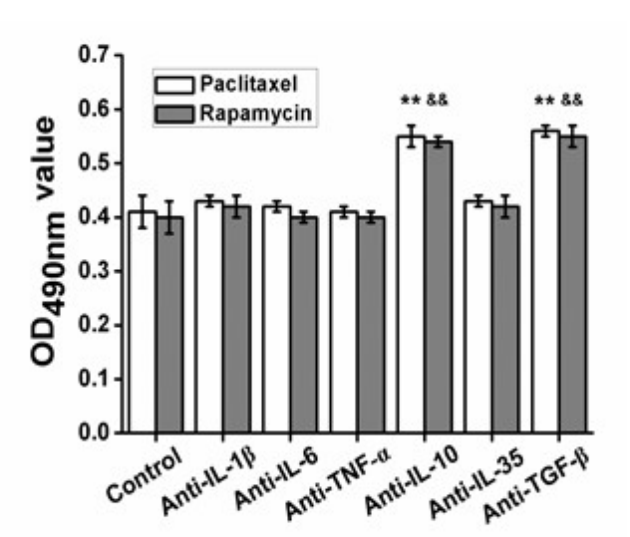
Fig. 4 - Effect of treatment with rapamycin or paclitaxel combined with cytokine antibody on foam cells proliferation.